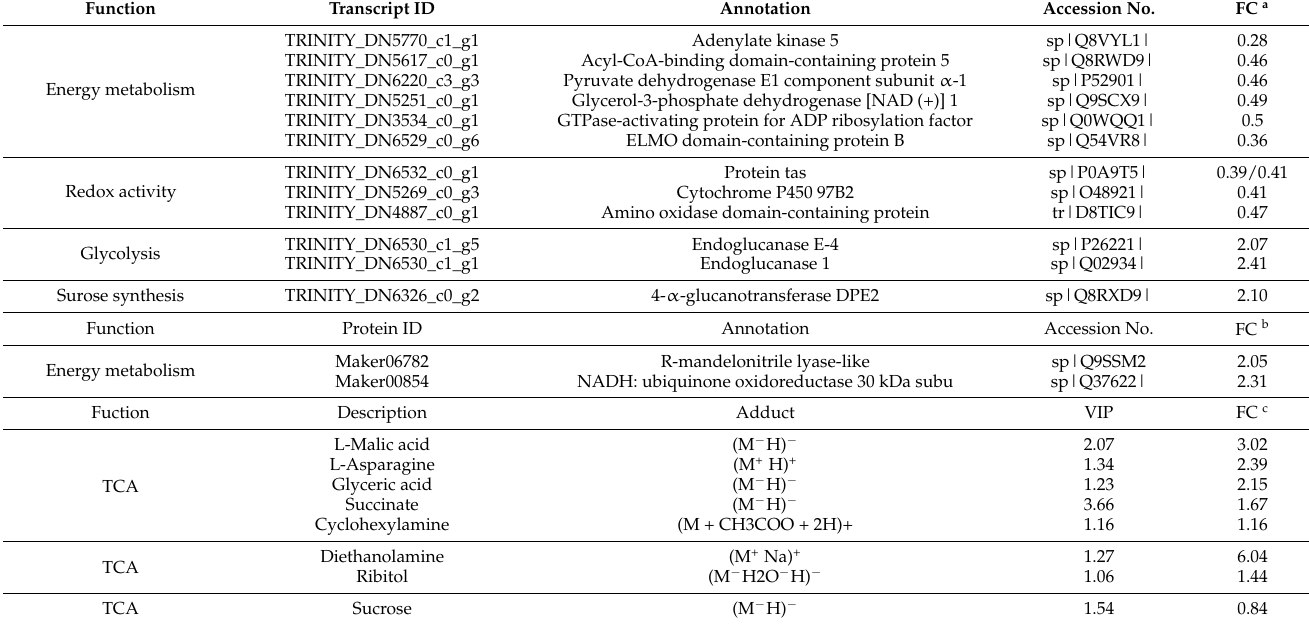
Table 2. Fluctuation of molecules in U. prolifera on energy metabolism after 12 h treatment with high